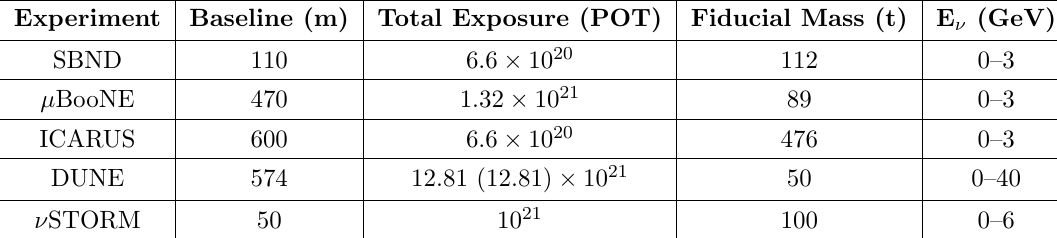
Table 2 . Summary of the LAr detectors set-up and values assumed in our calculations. The POT numbers are given for a neutrino (antineutrino) beam.